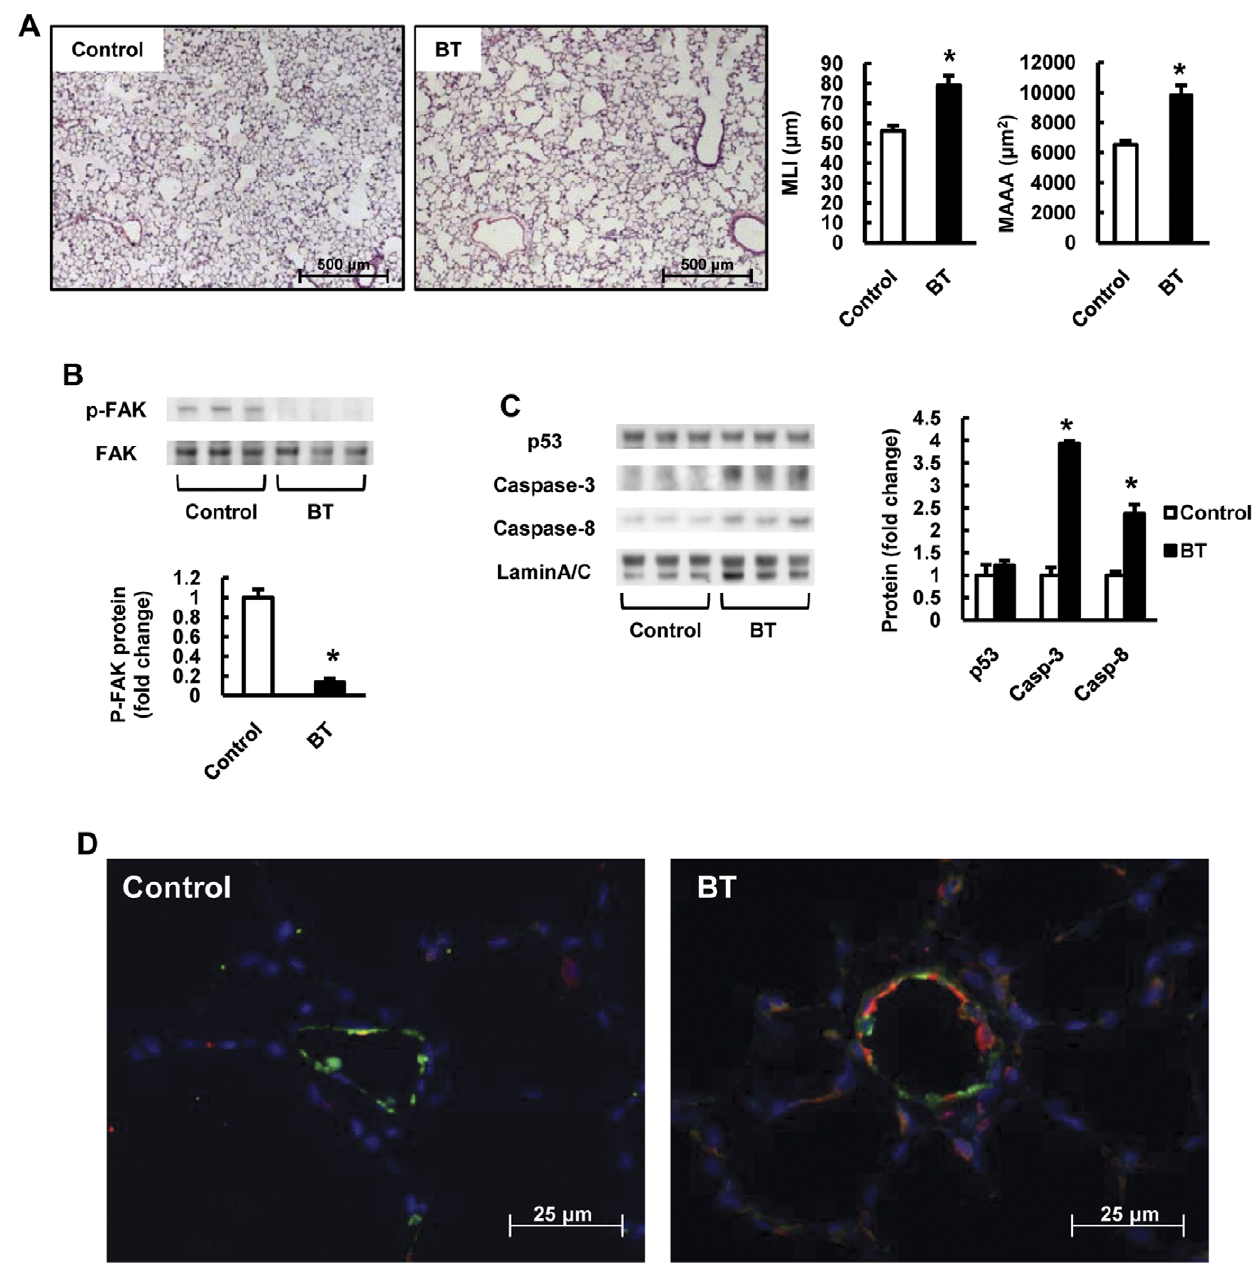
Figure 6. Inhibition of FAK phosphorylation causes emphysema and increases anoikis related protein expressions in rat lungs. (A) Representative photomicrographs of HE-stained lung sections of control and 1,2,4,5-benzenetetraamine tetrahydrochloride (BT) treated rats. The bar graph shows quantification of MLI and MAAA in lung sections from Control and BT treated rats. (B) Representative Western blot analysis of phospho- FAK at Y397 site and FAK in lung protein extracts from BT treated rats. The bar graph shows the ratios of phosphorylated protein expression relative to whole protein expression. (C) Representative Western blot analysis of p53, caspase-3, caspase-8 and Lamin A/C in lung nuclear protein extracts from BT treated rats. The bar graph shows the ratios of the protein expressions relative to control. Data are expressed as mean 6 SE (n=6). *P , 0.05 versus control. (D) Dual staining for Bim (red) and von Willebrand factor (vWF) (green) shows that the Bim positive cells are identified in and around the small pulmonary arteries from BT treated rat lungs. The blue color shows DAPI